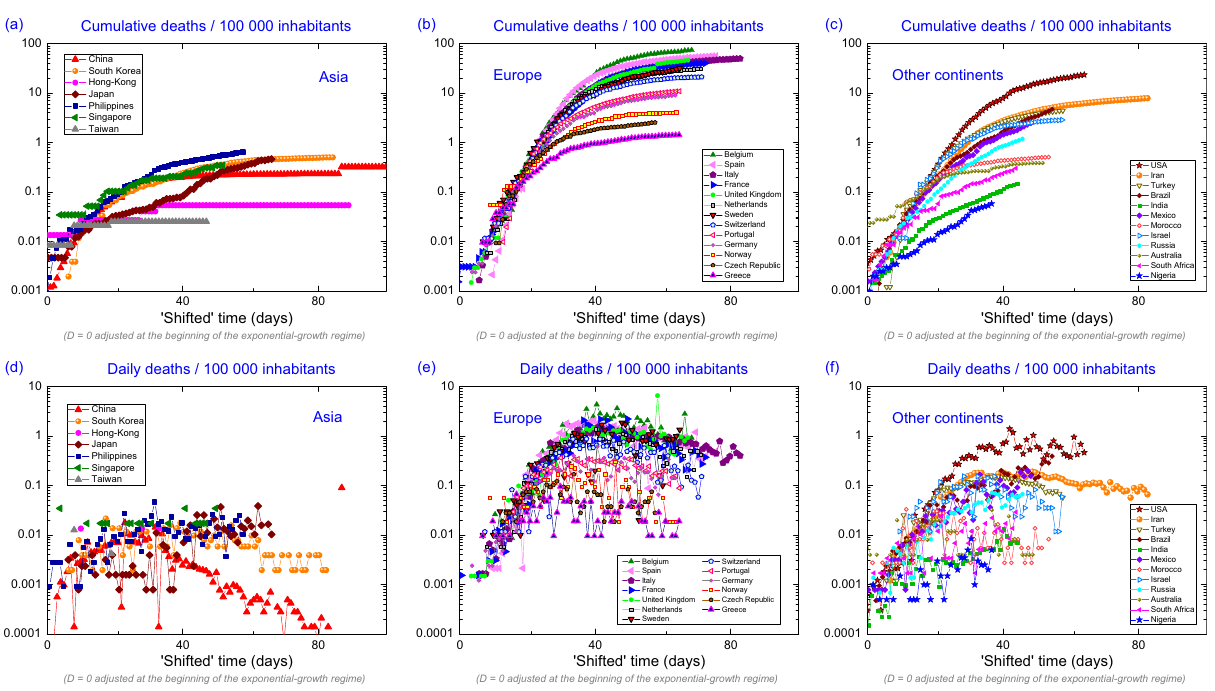
Figure 7. Cumulative and daily death tolls per 100,000 inhabitants for a selection of 32 countries worldwide. Cumulative deaths per 100,000 inhabitants versus “ shifted ” time (a) in Asian countries, (b) in European countries, and (c) in countries from other continents. Daily deaths per 100,000 inhabitants versus “ shifted ” time (d) in Asian countries, (e) in European countries, and (f) in countries from other